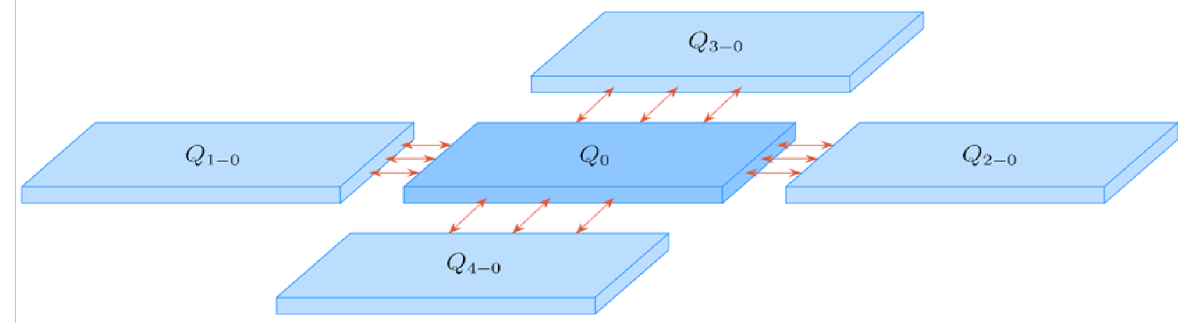
Figure 4. Wall–wall heat transfer